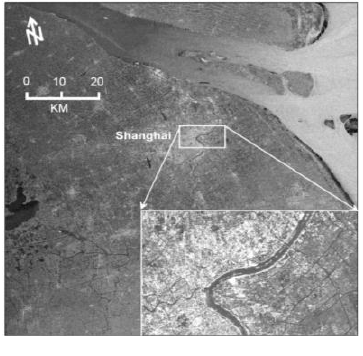
Fig. 4. The experiment area marked by a box onto the master amplitude